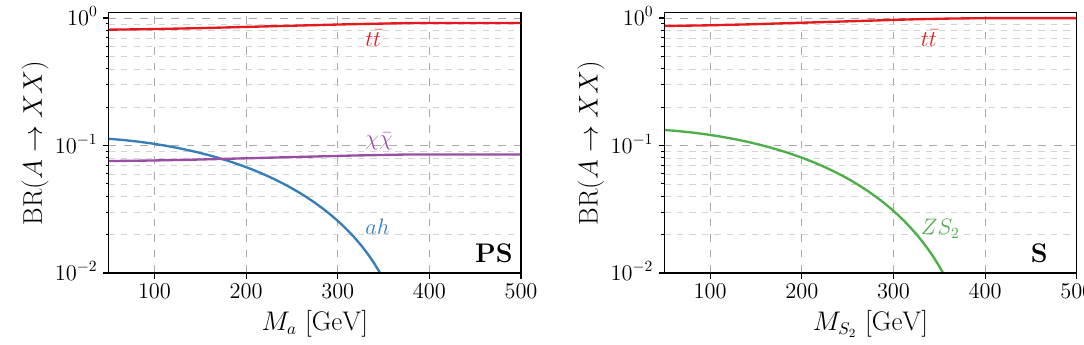
Figure 3 . Dominant branching ratios of the heavy scalar H=S 1 for tan (cid:12) = 1, M M A = 500 GeV, m (cid:31) = 10 GeV and other parameter values as given in eq. (4.4) in the 2HDM+PS (left) and 2HDM+S (right).